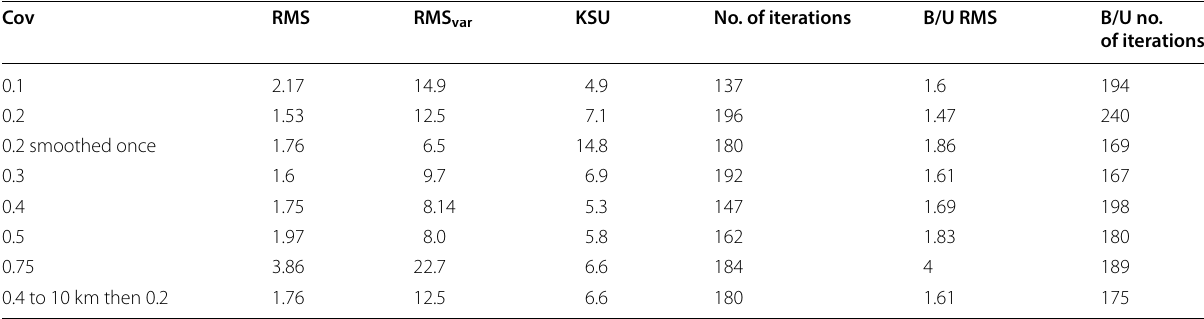
Table 2 Results of covariance